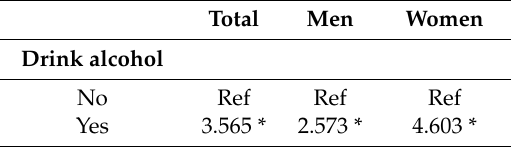
Table 3. Odds ratios of smoking among men and women according to drinking